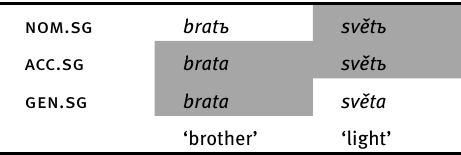
Table 5. Old Church Slavonic * o -stems nom.sg bratъ světъ acc.sg brata světъ gen.sg brata světa ‘brother’